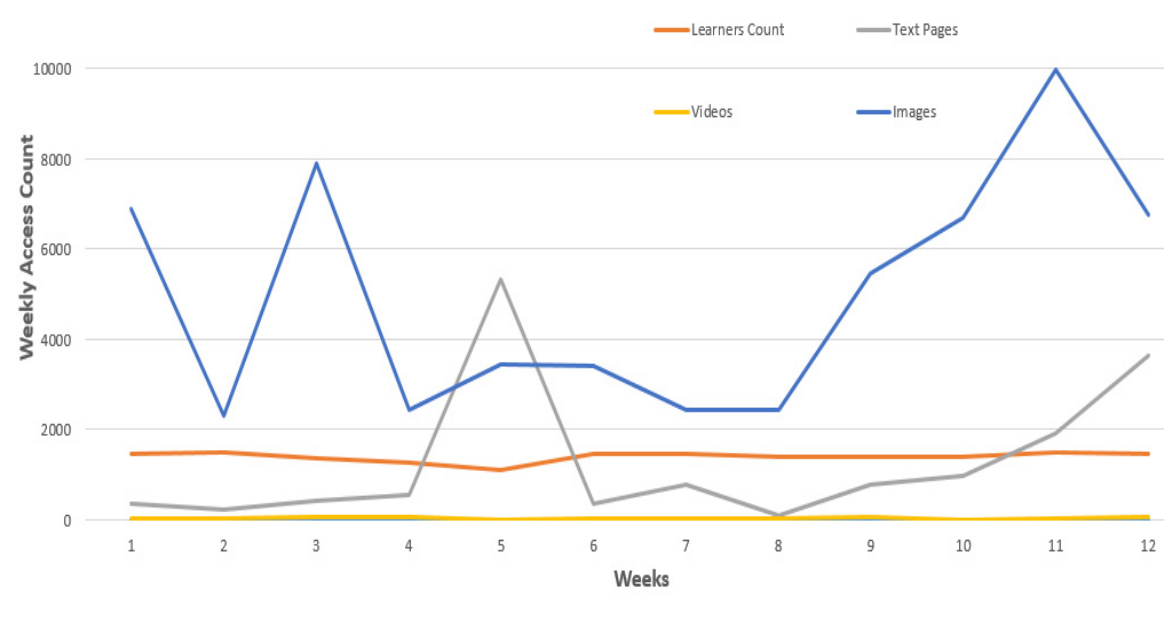
Figure 3. Weekly access count of learning resources.